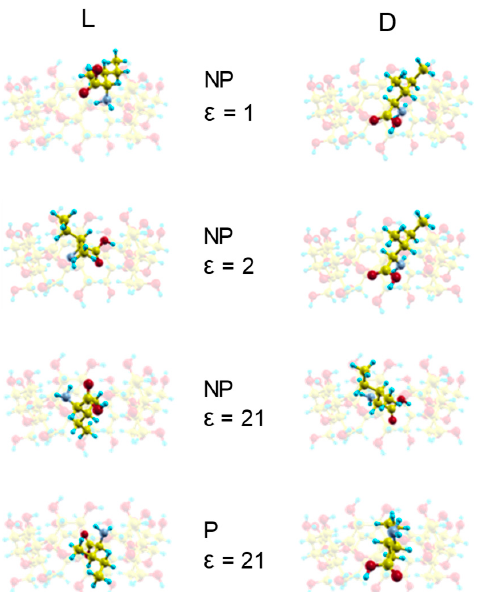
Figure 1. The complex configurations with minimum interaction energies E min for ε = 1 (NP structure), ε = 2 (NP structure), ε = 21 (NP structure) and ε = 21 (P structure). NP and P structures are neutral and zwitterion configurations respectively. The guest molecule has been superimposed for clarity.